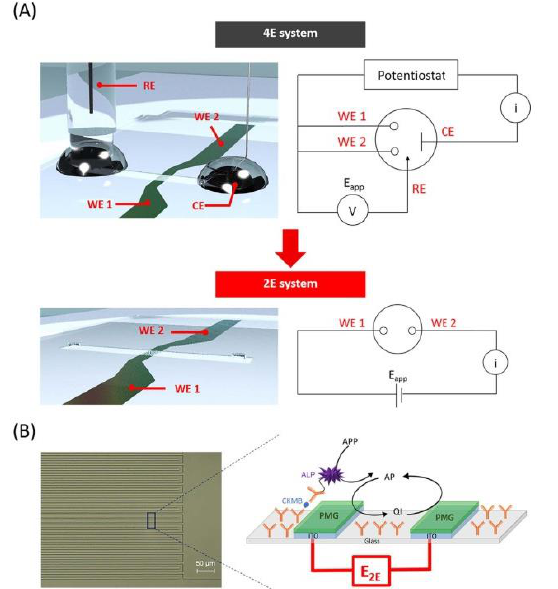
Figure 8. ( A ) Scheme of four-electrode (4E) and two-electrode (2E) systems in IDEA microchip; ( B ) optical microscopic image of IDEA and schematic representation of electrochemical immunoassay in IDEA microchip. Illustrations of cross-sectional view of IDEA surface showing immobilization of antibodies onto a glass substrate, where ITO is etched, followed by immobilization of PMG with dopamine (DA) onto ITO. Reprinted from Ref. [146]. Copyright © 2022 Elsevier B.V. Table 2. Comparison between carbon-based 2D IDEA (2D C-IDEA) and carbon-based 3D IDEA (3D C-IDEA) sensor performance using CV based on amperometric technique.